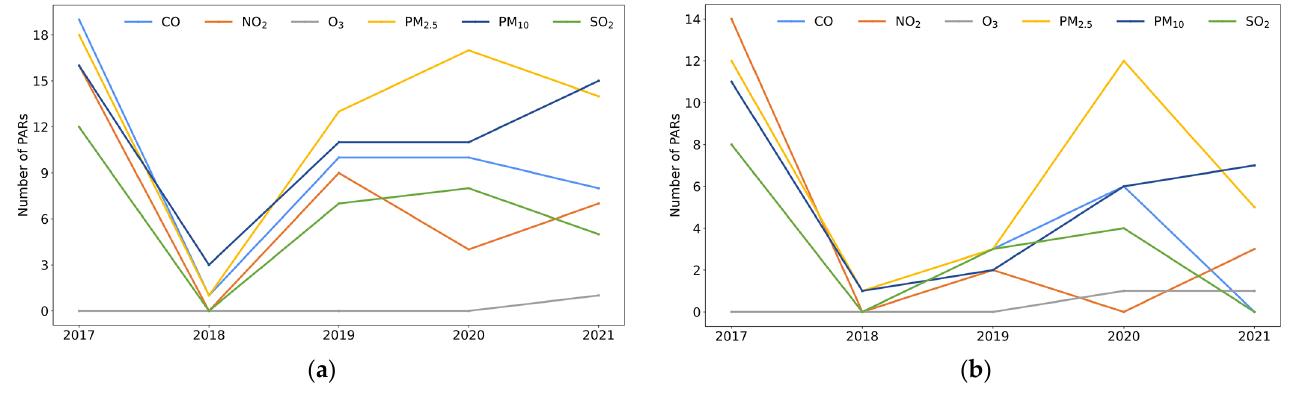
Figure 5. Number of PARs with a significant and positive correlation between air pollution and related Weibos in each year of 2017–2021 for: ( a ) APR Weibos; ( b ) HR Weibos. related Weibos in each year of 2017–2021 for: ( a ) APR Weibos; ( b ) HR